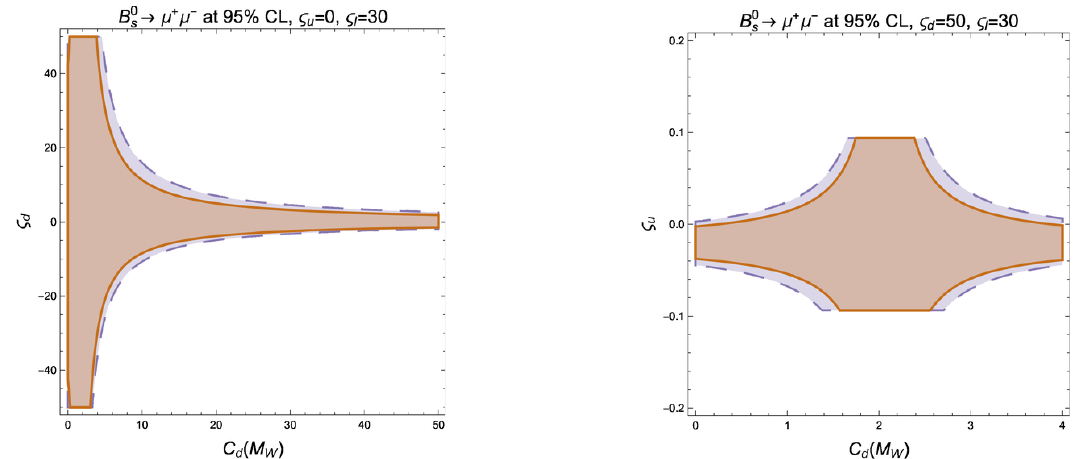
Figure 6. The left (right) panel shows the B 0 ! (cid:22) + (cid:22) (cid:0) constraints (95% CL) on C d ( M W ) and & d s ( & u ), in the CP-conserving limit, for (cid:21) 3 = (cid:21) 7 = 1, c ~ (cid:11) = 0 : 95 and & l = 30, with & u = 0 ( & d = 50) and the two heavy-mass con(cid:12)gurations in eq. (7.3): E (orange, solid line) and F (violet,